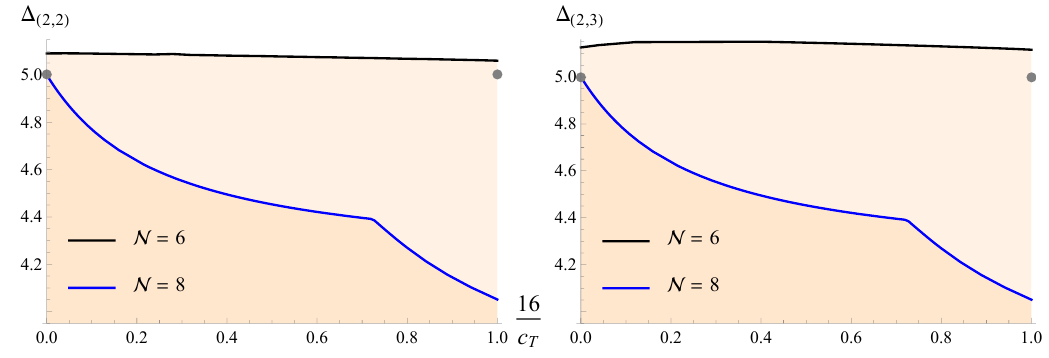
Figure 7 . Upper bounds on the scaling dimension of the lowest dimension ‘ = 2 long multiplet in terms of c T for the Long [000] , 2 ( left ) and Long [000] , 3 ( right ) superconformal structures, which for ∆ , 2 ∆ , 2 parity preserving theories have the opposite parity as the superprimary, and for Z preserving theo- ries has the same charge for Long [000] , 2 and the opposite charge for Long [000] , 3 . The orange shaded ∆ , 2 ∆ , 2 region is allowed, and the plot ranges from the GFFT limit c T → ∞ to the free theory c T = 16 . The black lines denotes the N = 6 upper bounds computed in this work with Λ = 39 , the blue lines denote the N = 8 upper bounds computed in [10] with Λ = 43 . At c T = 16 the N = 8 upper bound does not apply, as the N = 8 superblock becomes a conserved current that does not decompose to Long [000] , 2 or Long [000] , 3 . The gray dots denote the GFFT and free theory values from table ∆ , 2 ∆ , 2